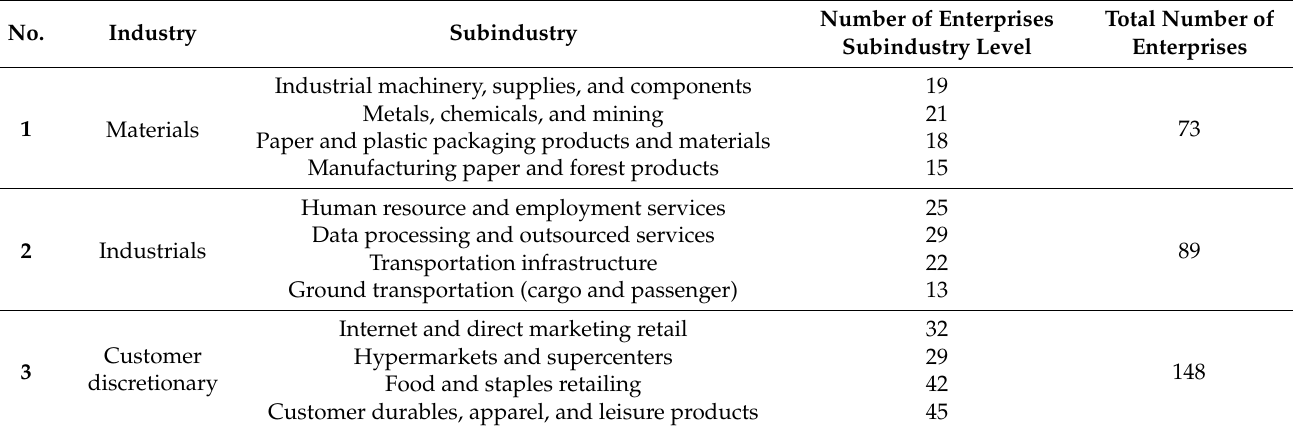
Table 2. Categorization of enterprises based on